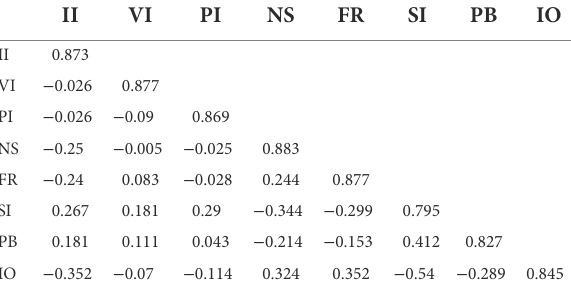
TABLE 3 Factor correlation coefficients and square roots of the